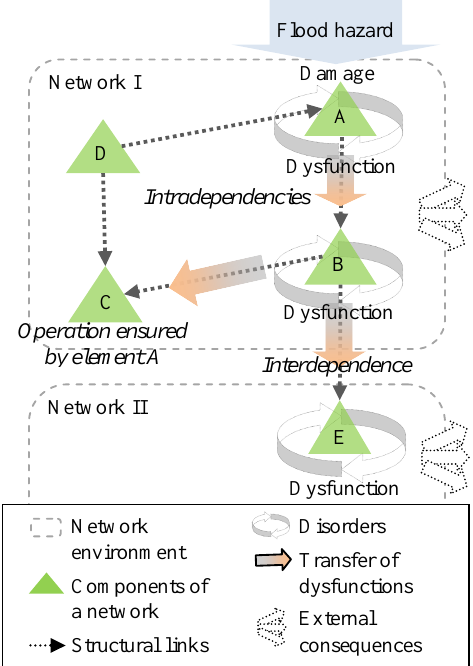
Figure 1. Relationships between network infrastructures in case of flooding. 2 Fig. 1. Relationships between network infrastructures in case of